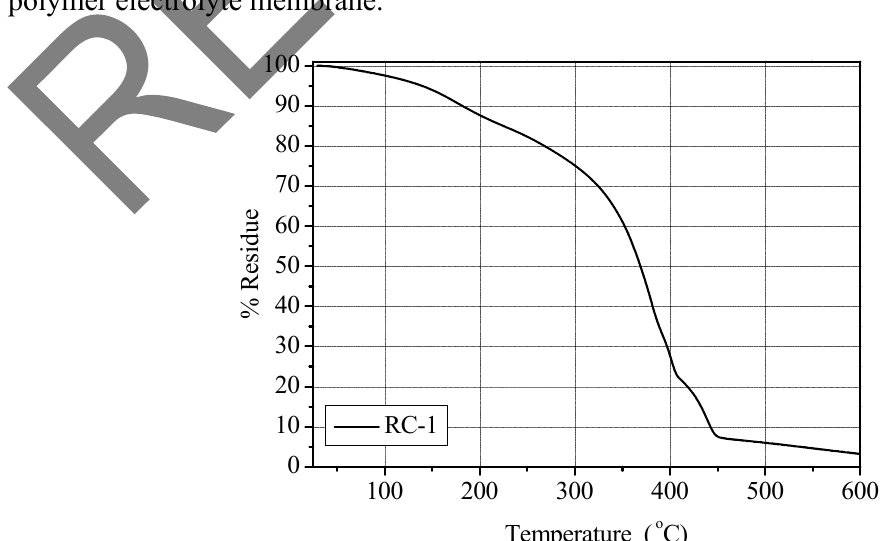
Figure 2. TGA analysis under N polymer electrolyte